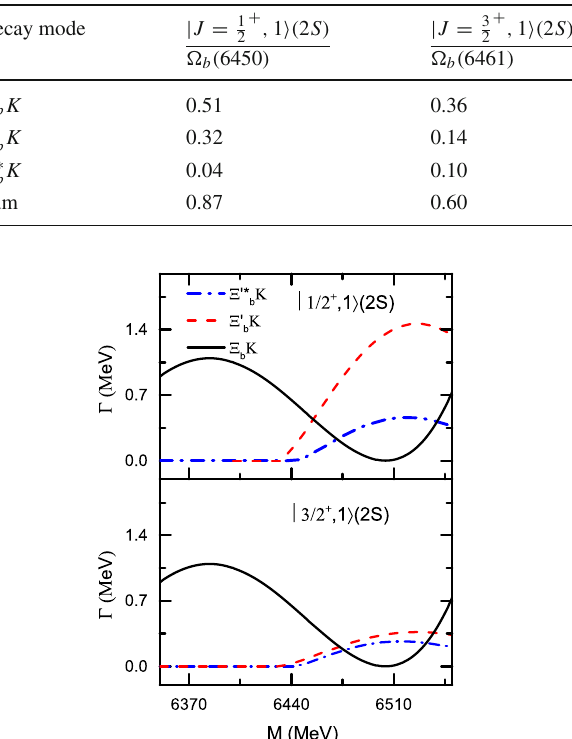
2 S states. Our results have been listed in Table 5. From the table, we get that the two 2 S states may be narrow state with a comparable total decay width of (cid:4) ∼ 1